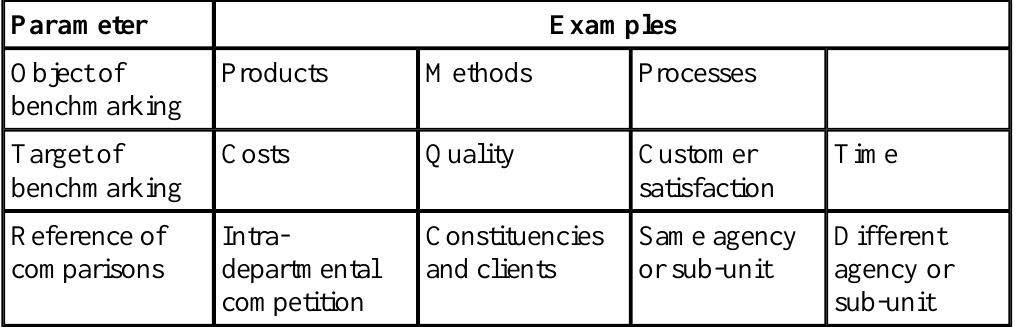
Table 2 Forms of benchmarking (Szulanski and Winter